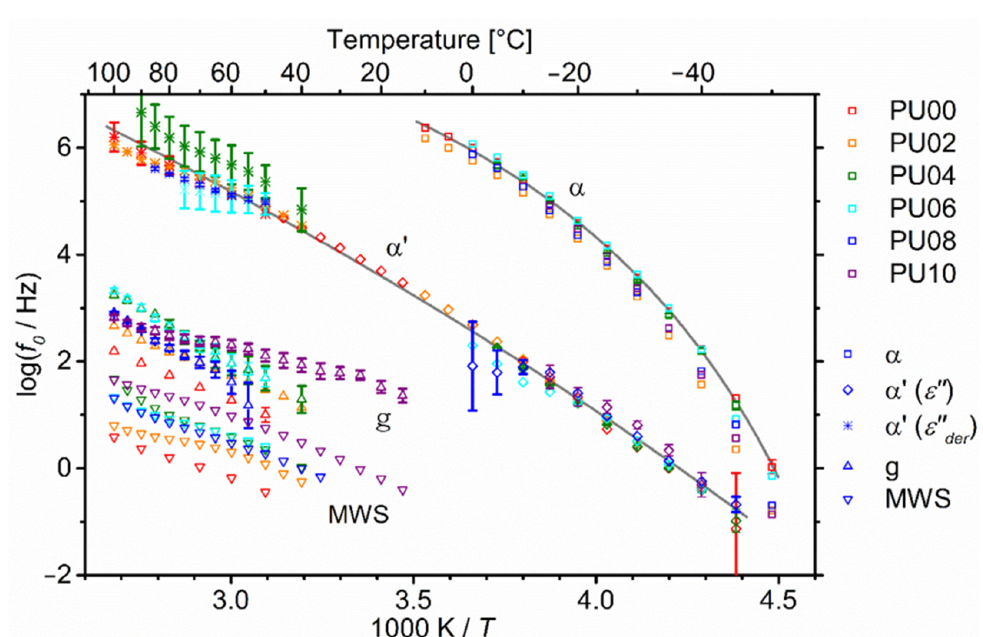
Figure 11. Arrhenius plot (activation diagram) for all the procedures identified in the dielectric spectra. Lines are fits of Vogel Fulcher Tammann equations (details in text). Error bars are shown only if larger than the corresponding point.